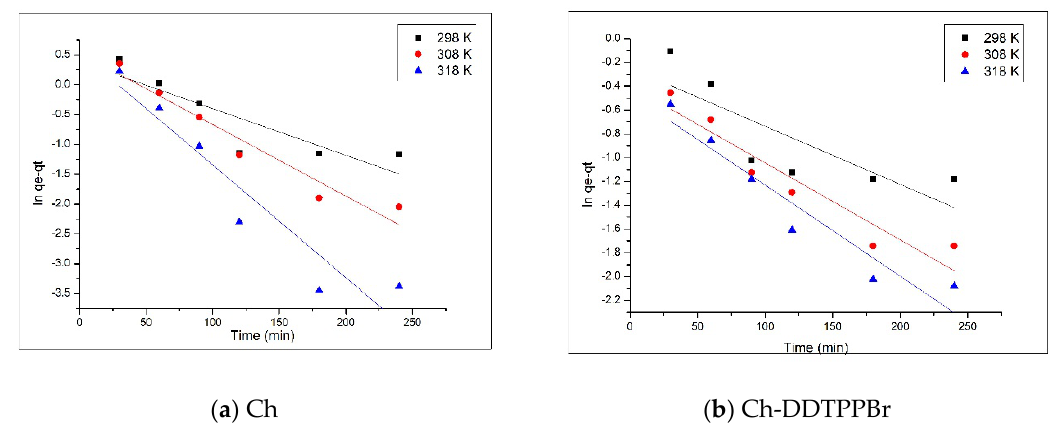
Figure 6. Pseudo first-order kinetic model ( a ) Ch; ( b ) Ch-DDTPPBr.